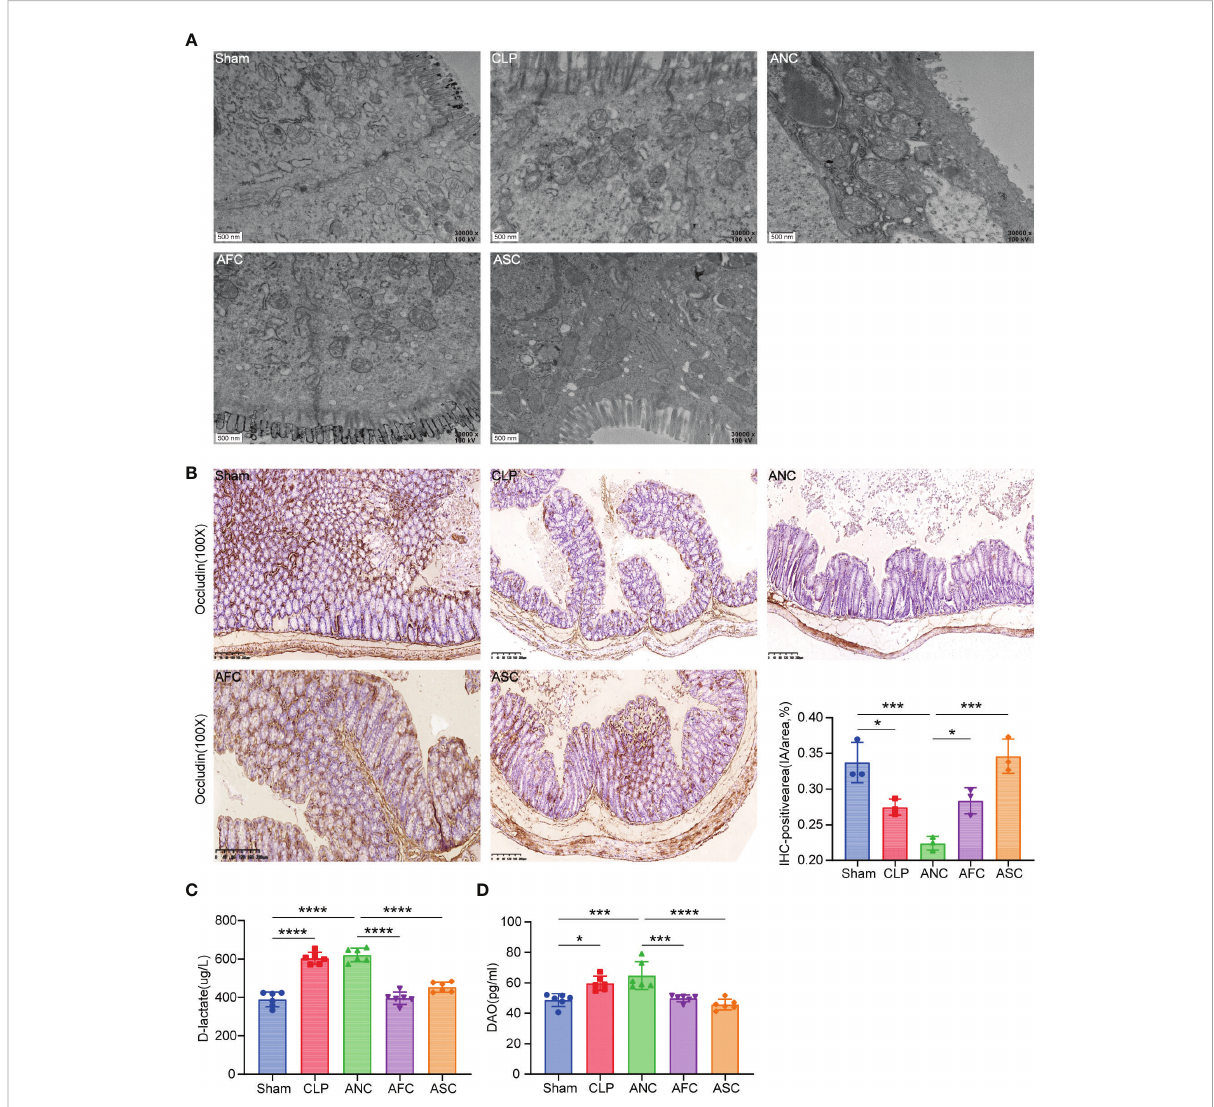
FIGURE 4 Fecal microbiota transplantation (FMT) and supplementation with short-chain fatty acids (SCFAs) protect the mouse intestinal epithelial tight junction from CLP-induced damage. (A) Electron micrograph of colonic segments taken from mice with different treatments. Groups are labeled as shown. Scale bar =500 nm. (B, C) Immunohistochemical staining of tight junction proteins Occludin, in colon tissues (X 100, scale bar, 100 m m). Signi fi cant results are shown in the box plot. (D) Serum D-lactate and diamine oxidase (DAO) levels. *P < 0.05; ***P < 0.001; ****P <